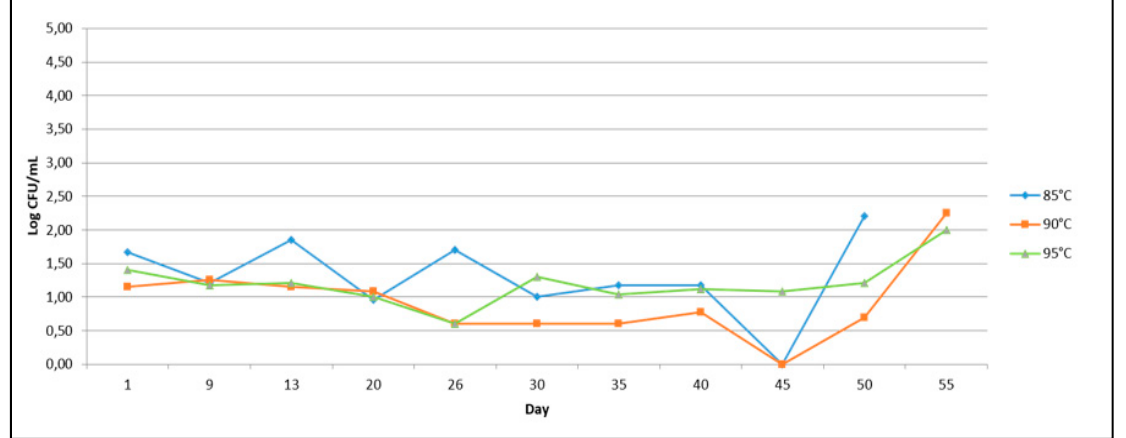
Figure 8. Measurements of TMC during a storage period of 55 days at 4°C.